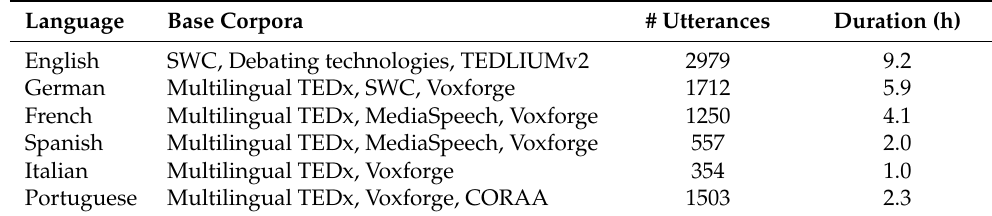
Table 2. Data distribution for the GRACE dataset, which combines different corpora into a single one within the child abuse